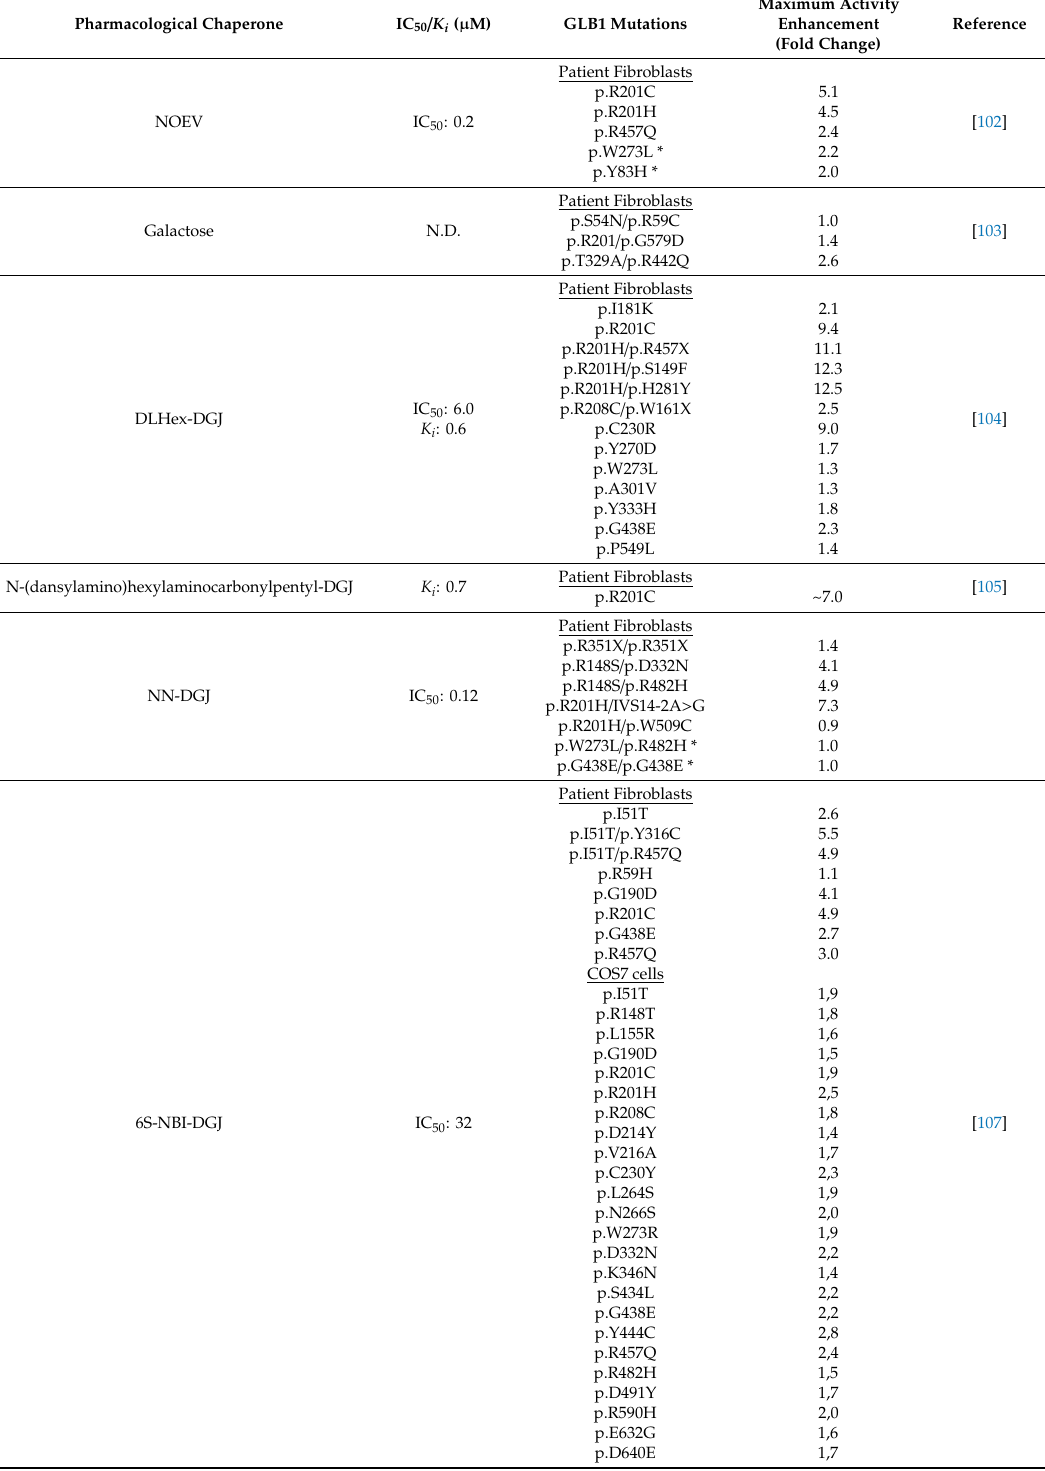
Table 2. Summary of the e ff ect on enzyme activity of pharmacological chaperones for GLB1 deficiencies. Pharmacological Chaperone IC 50 / K i ( µ